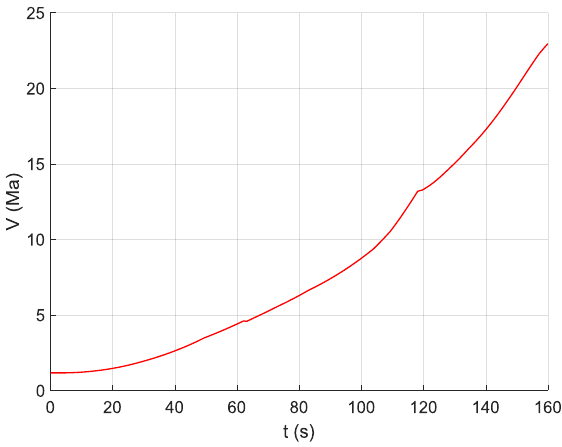
Figure 5. Velocity curve of aircraft in inertial coordinate.